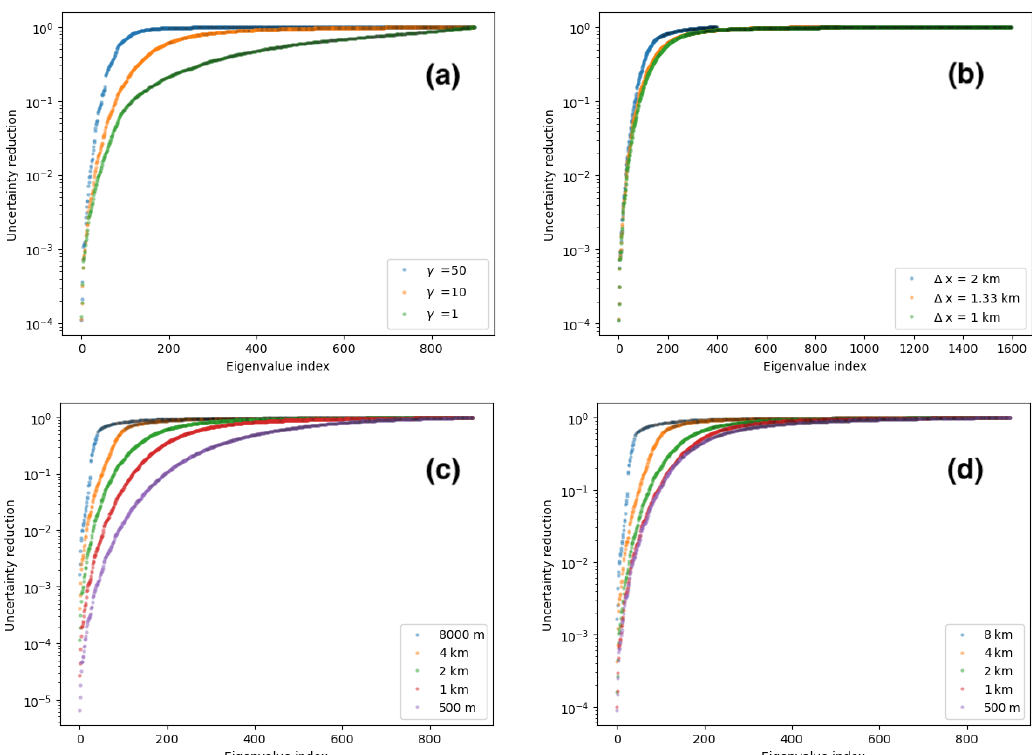
Figure 4. Uncertainty reduction factor 1 /( 1 + λ k ) versus eigenvalue index k for a range of experiments. (a) Dependence of reduction spectra on the regularization parameter γ α . (b) Dependence of reduction spectra on model resolution. (c) Dependence of reduction spectra on the density of observational sample points. (d) Dependence of reduction spectra on the density of observational sample points with nonzero observational covariance.